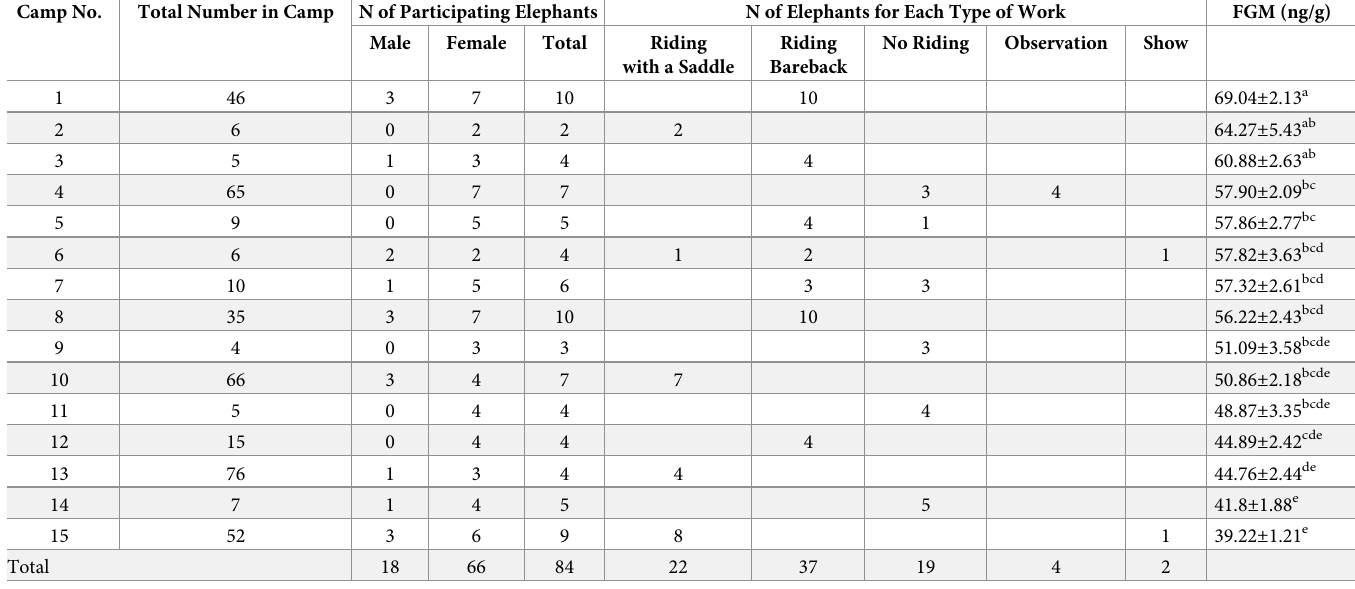
Table 1. Summary of elephants and mean ( ± SEM) fecal glucocorticoid metabolite (FGM) concentrations of elephants at 15 elephant camps in Chiang Mai province. Camp